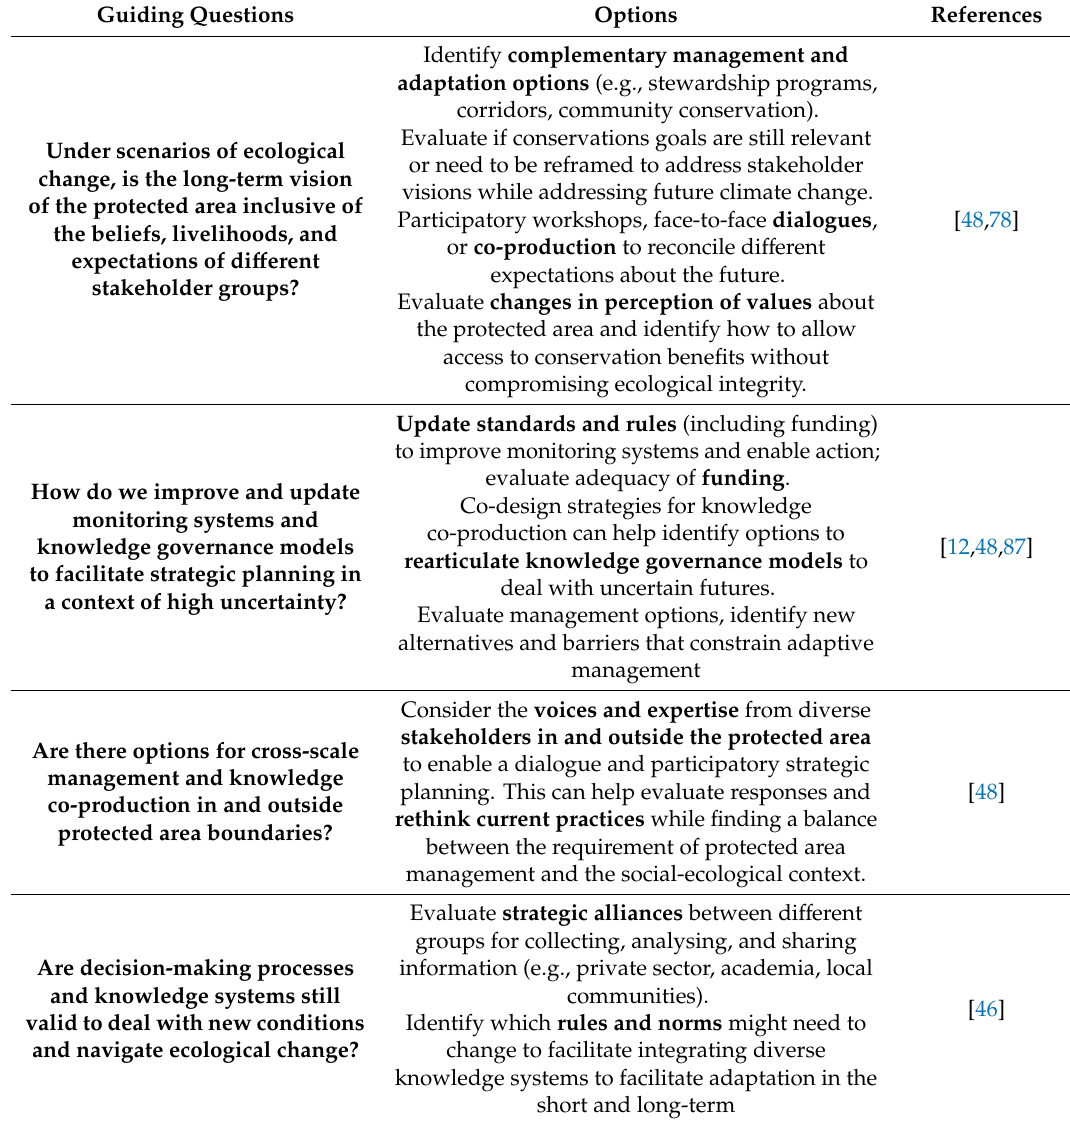
Table A3. Guiding questions for protected area managers to facilitate the reflexivity process in multidimensional knowledge-based processes at the strategic planning level. Words highlighted in bold represent some key ideas and issues to